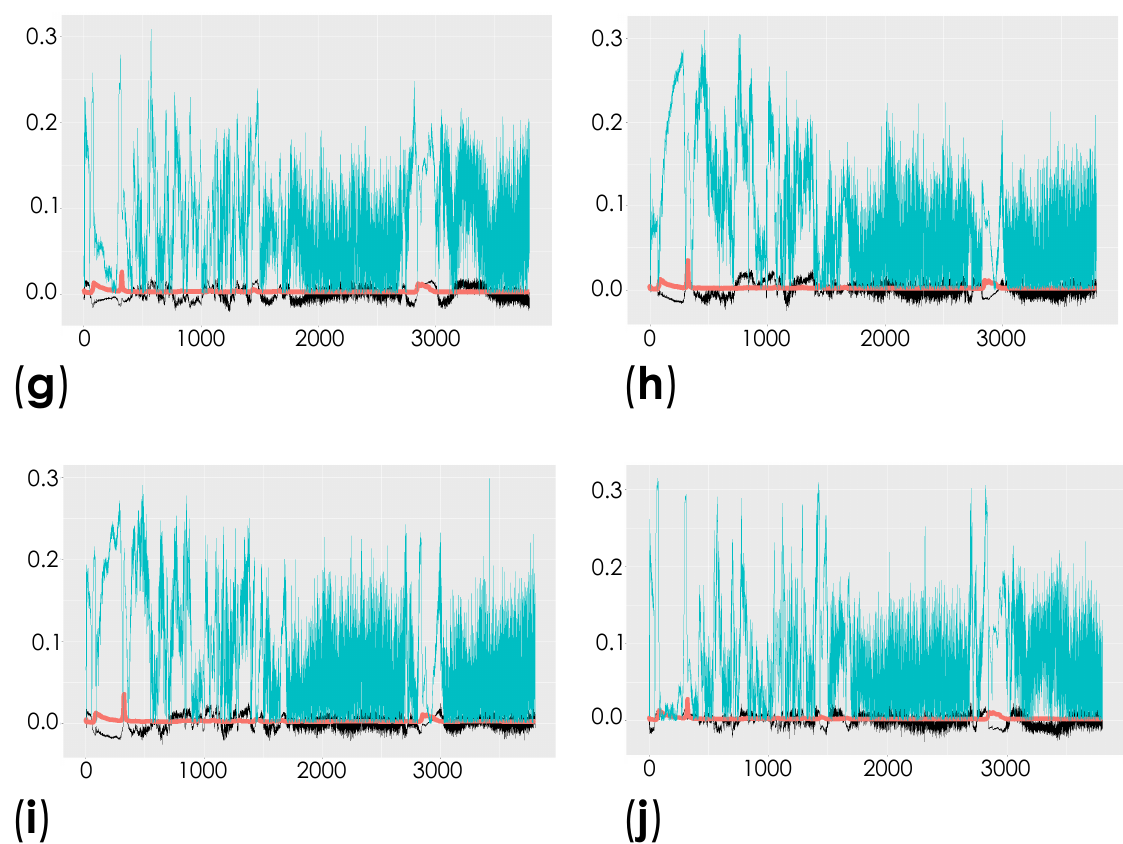
Figure 4. Representation of the coefficient loading plots of the Raman spectra of the unlabeled dECM samples. Different groups were compared: control versus saline contralateral hemisphere (SAL CT) ( a ); control versus saline ipsilateral hemisphere (SAL IP) ( b ); control versus 6-OHDA-lesioned contralateral hemisphere (PD CT) ( c ); control versus 6-OHDA- lesioned ipsilateral hemisphere (PD IP) ( d ); saline contralateral hemisphere (SAL CT) versus saline ipsilateral hemisphere (SAL IP) ( e ); saline contralateral hemisphere (SAL CT) versus 6-OHDA-lesioned contralateral hemisphere (PD CT) ( f ); saline contralateral hemisphere (SAL CT) versus 6-OHDA-lesioned ipsilateral hemisphere (PD IP) ( g ); saline ipsilateral hemisphere (SAL IP) versus 6-OHDA-lesioned contralateral hemisphere (PD CT) ( h ); saline ipsilateral hemisphere (SAL IP) versus 6-OHDA-lesioned ipsilateral hemisphere (PD IP) ( i ); 6-OHDA-lesioned contralateral hemisphere (PD CT) versus 6-OHDA-lesioned ipsilateral hemisphere (PD IP) ( j